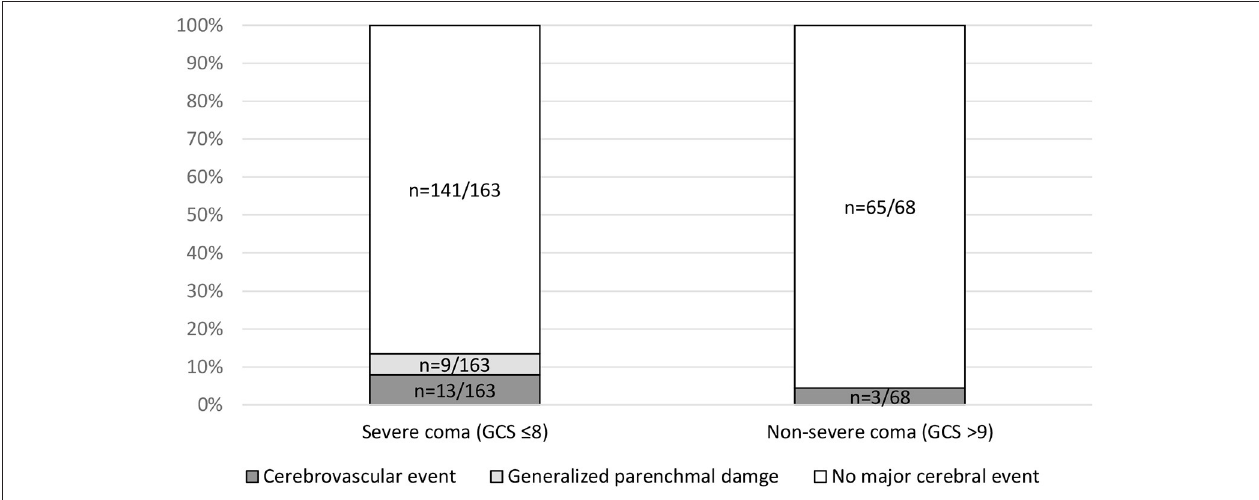
FIGURE 2 | Association of major cerebral events and Glasgow Coma Scale (GCS). Subgroups with severe coma (GCS ≤ 8) vs. non-severe coma were compared using a contingency table analysis for the parameters cerebrovascular events ( p = 0.30), generalized parenchymal damage ( p = 0.05), and major events ( p = 0.04). GCS was available in 231 cases.